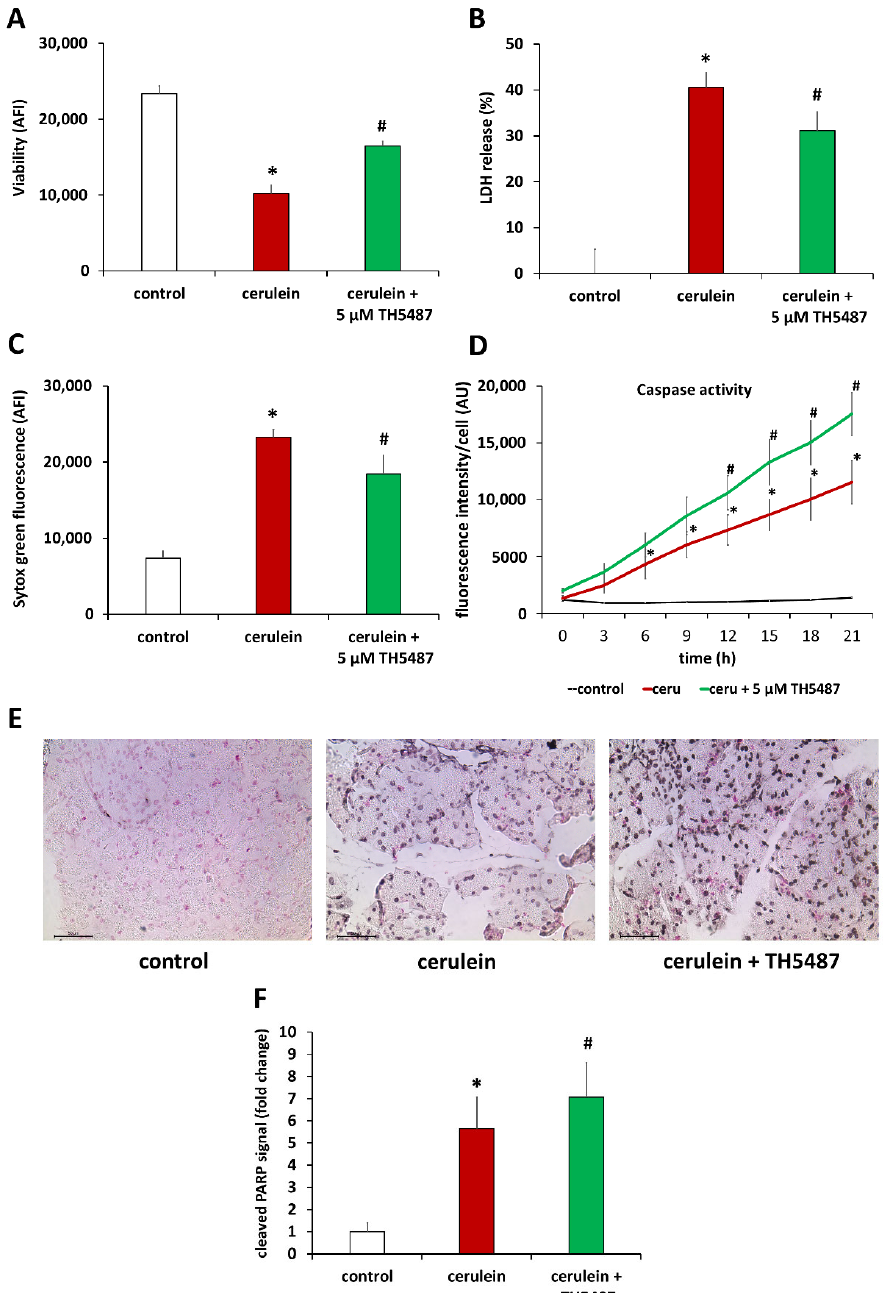
Figure 5. OGG1 inhibition increase cell viability by promoting apoptosis and reducing necrosis. ( A ) OGG1 inhibition increased viability in primary acinar cells and reduced necrosis as shown by decreased LHD level ( B ) and Sytox Green intensity ( C ). OGG1 inhibition increased apoptosis in primary acinar cells ( D ), which correlates to the results of immunohistochemical staining of pancreas sections for cleaved PARP ( E ). ( F ) Cleaved PARP formation increased in cerulein-treated mice compared to the controls and increased significantly further in TH5487 treatment group.